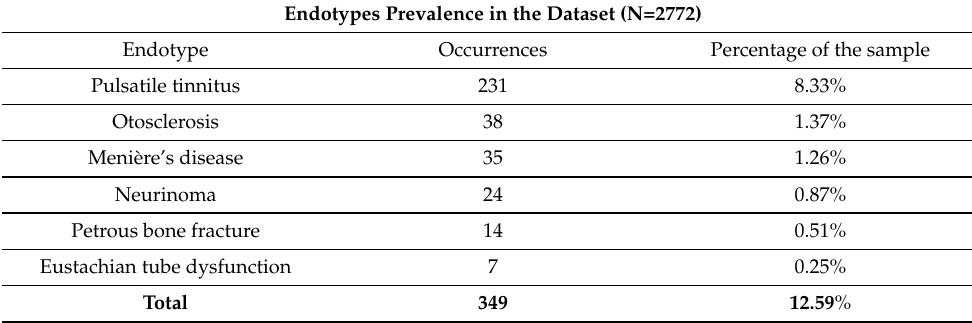
Table 4. Endotypes’ prevalence in the